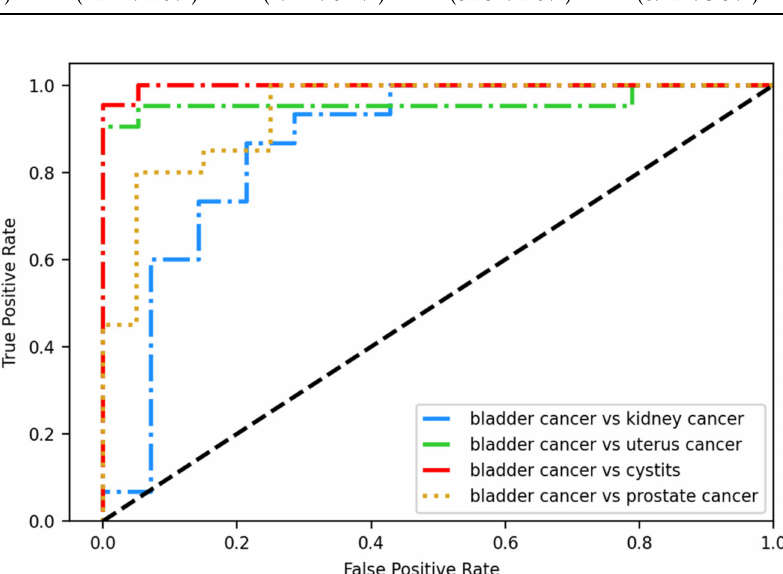
Figure 4. The receiver operating characteristic curve (ROC) plot of separating bladder cancer from cystitis or other